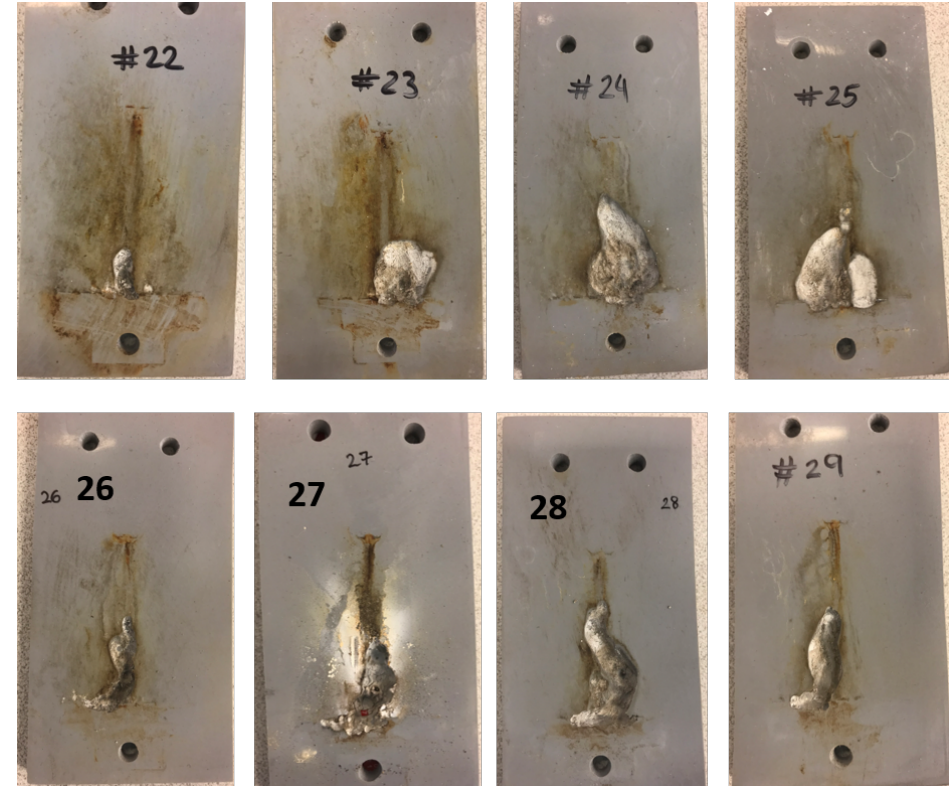
Figure A3. Photographs of test specimens #22–#29 at the end of + DC